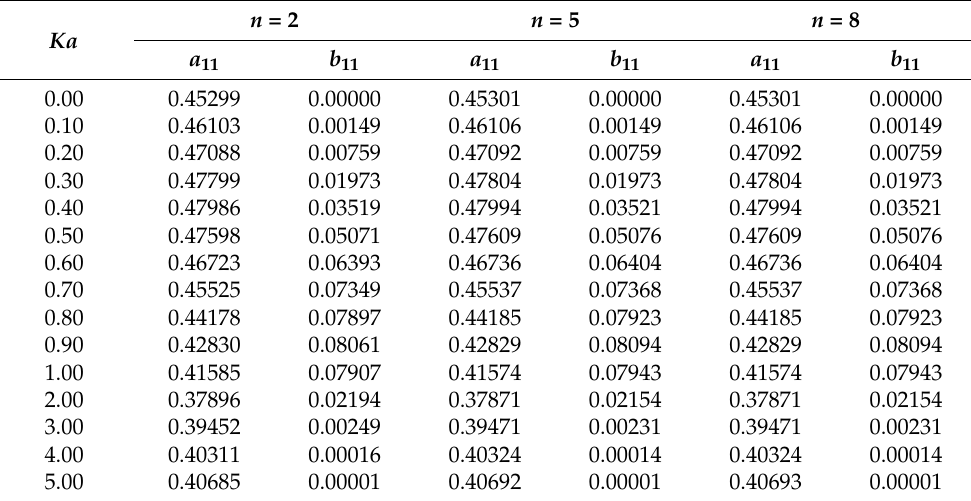
Table 1. Convergence sequence of the normalized surge added mass and damping coefficients for several numbers of modes (oblate spheroid with a / b = 1.25, immersion f = 1.5 a and water depth h = 10 a ).